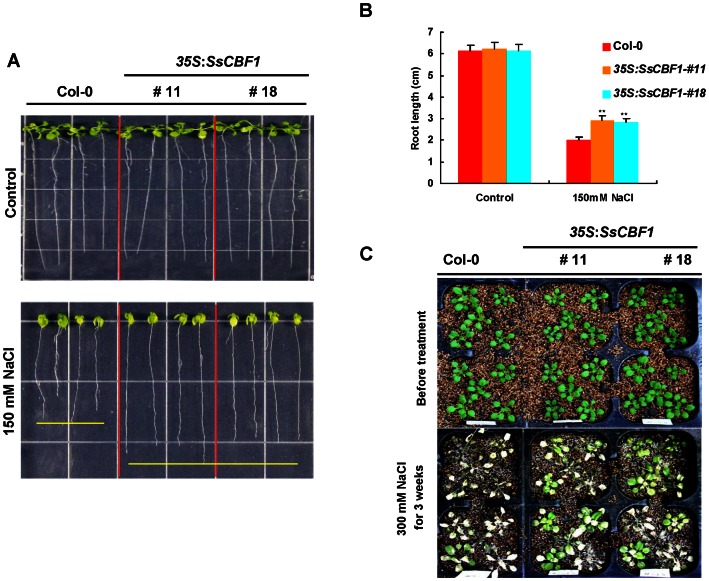
Effects of high salinity on root lengths of Col-0 and SsCBF1 transgenic lines.(A) Representatives of Col-0 and two OE lines treated with 150 mM NaCl. Seeds of each genotype were germinated and grown vertically on MS medium for 4 d and then transferred to fresh MS medium containing 150 mM NaCl. Photographs were taken after 11d of growth. (B) Measurements of primary root lengths of plants shown in (A). All values are average and SD (n = 15). Asterisks denote Student's t test significance compared with Col-0 plants: **P<0.01. (C) High-salinity tolerance of Col-0 and two transgenic adult plants. 3-week-old plants (before treatment, upper panel) were irrigated with 300 mM NaCl solution every 3 d for 3 weeks. Bottom panel was photographed 3 weeks after the onset of irrigation.